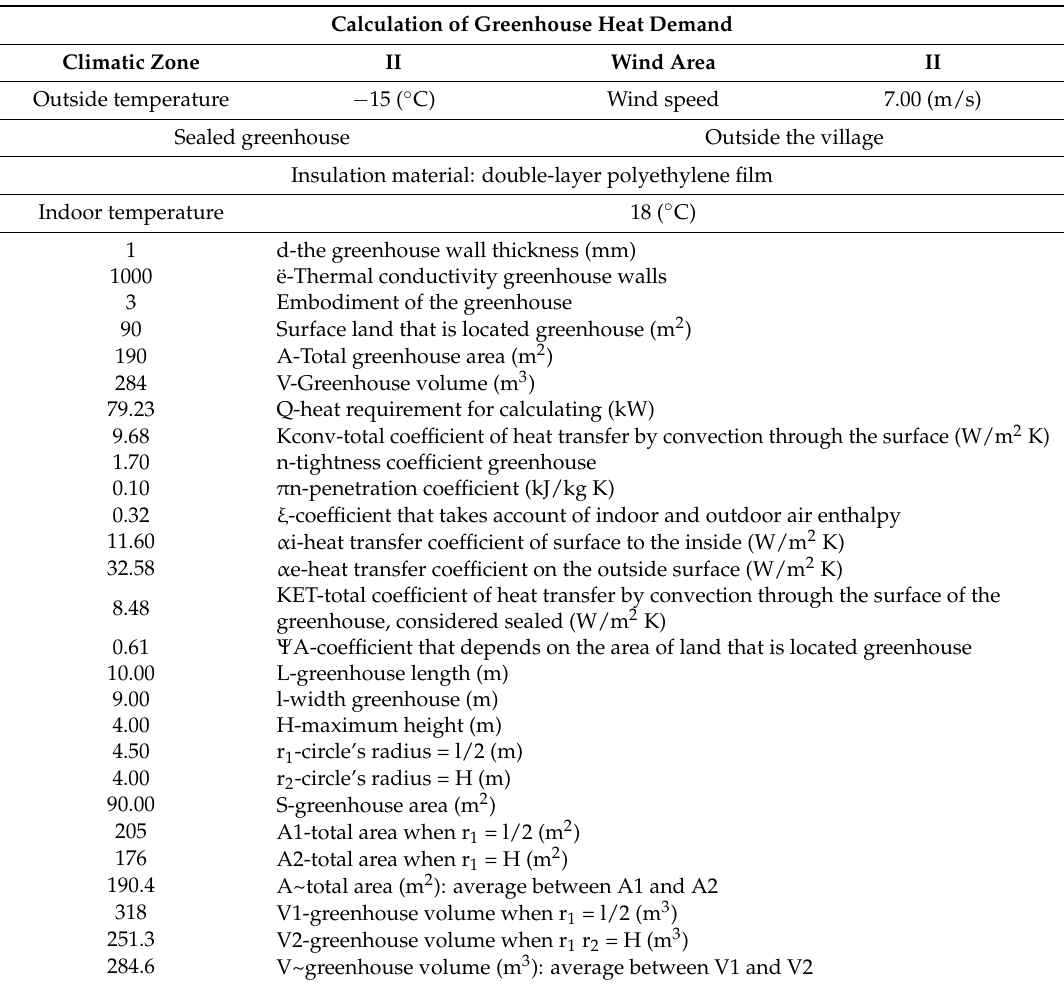
Table 1. Calculation of greenhouse heat